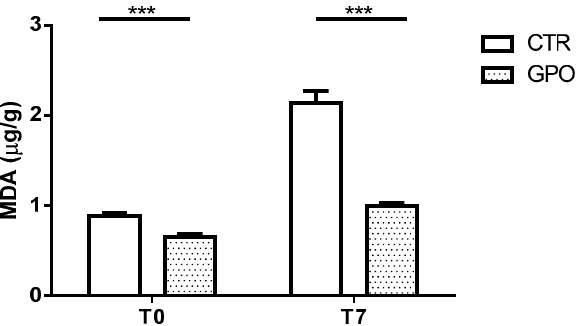
Figure 6. Malondialdehyde (MDA) levels at 0 (0.89 ± 0.03 vs. 0.65 ± 0.04) and 7 (2.14 ± 0.14 vs. 0.99 ± 0.03) days from slaughter in meat stored at 4 °C. Data represent mean ± SD, ***: p < 0.001, two-way ANOVA (5 samples/group).